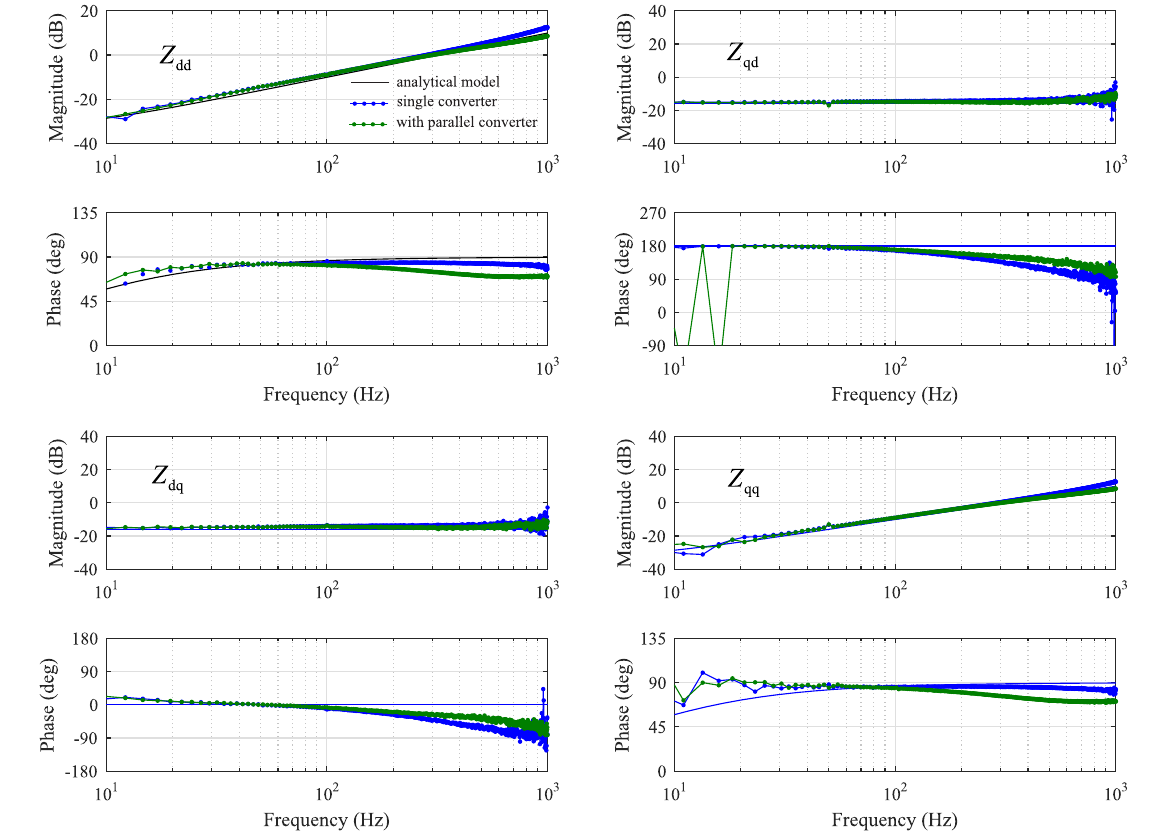
Figure 13. Measured impedance with parallel-connected current-controlled